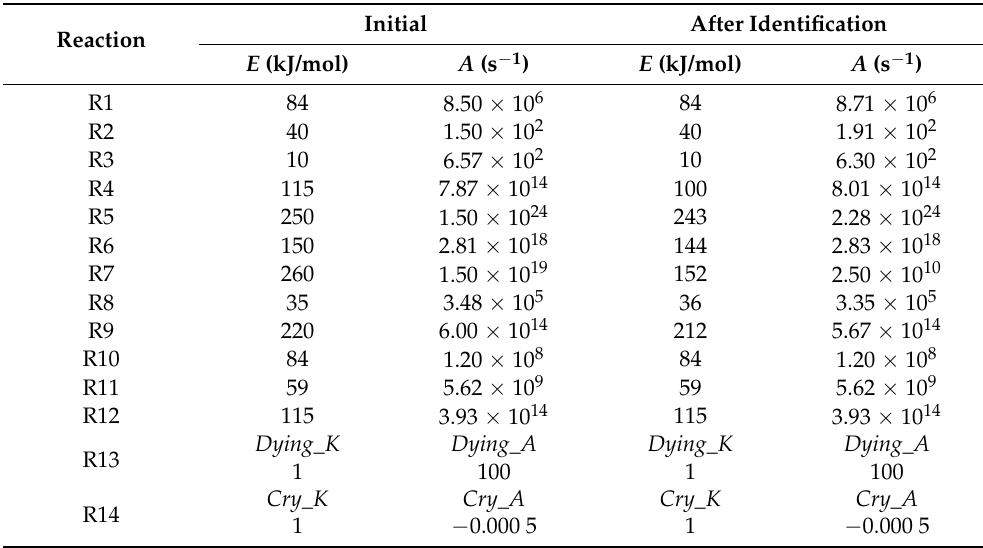
Table 9. The identification results of reaction kinetic parameters.